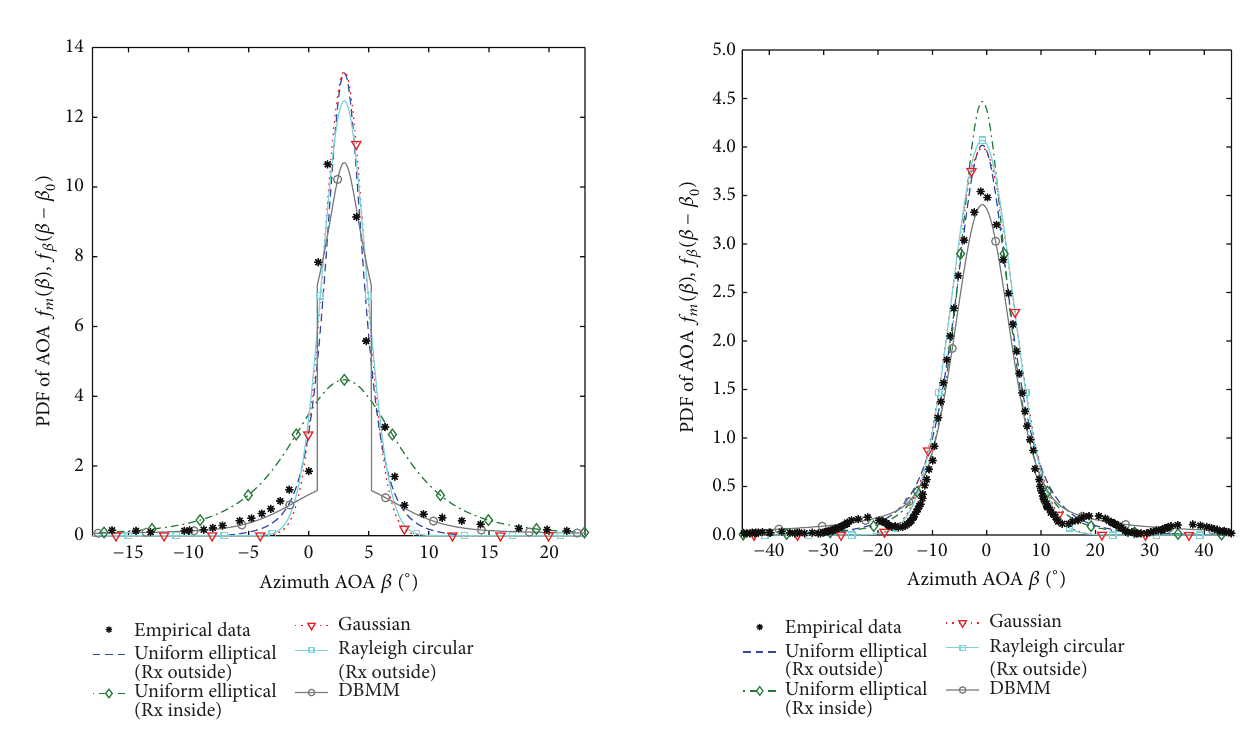
Figure 9: Fitting for various geometric models to the empirical data in Mogensen et al. [30, Figure 3